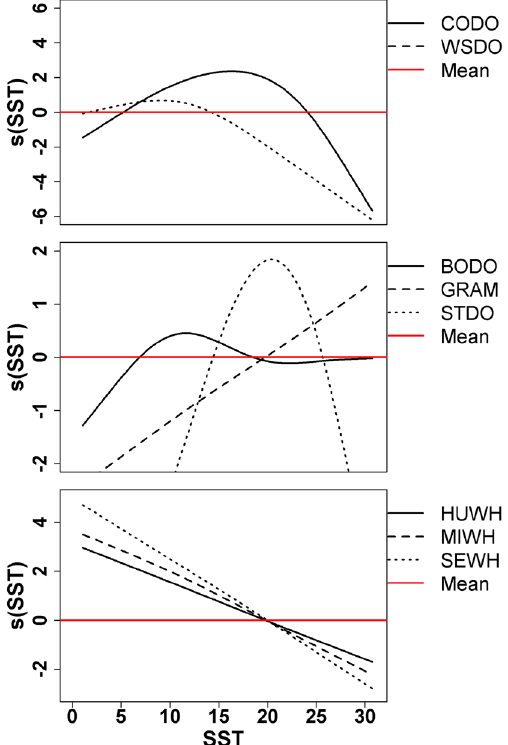
Figure 2. Examples of the partial effect of SST (°C) on the changes in abundance relative to its mean for common dolphin (CODO), white-sided dolphin (WSDO), common bottlenose dolphin (BODO), Risso’s dolphin (GRAM), striped dolphin (STDO), humpback whale (HUWH), minke whale (MIWH), sei whale